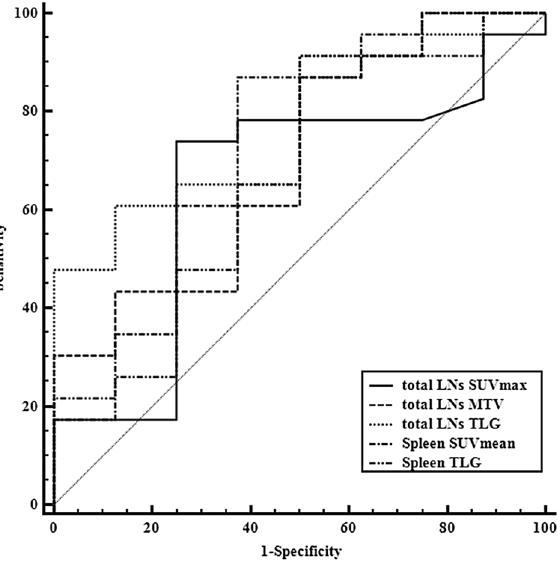
Figure 2. Receiver operating characteristic curve of metabolic parameters in Kikuchi-Fujimoto disease. The areas under the curve (AUC) for total lymph nodes, TLG, and spleen SUV mean are higher than that of total lymph nodes MTV. SUV mean , mean standardized uptake value; MTV, metabolic tumor volume; TLG, total lesion glycolysis.